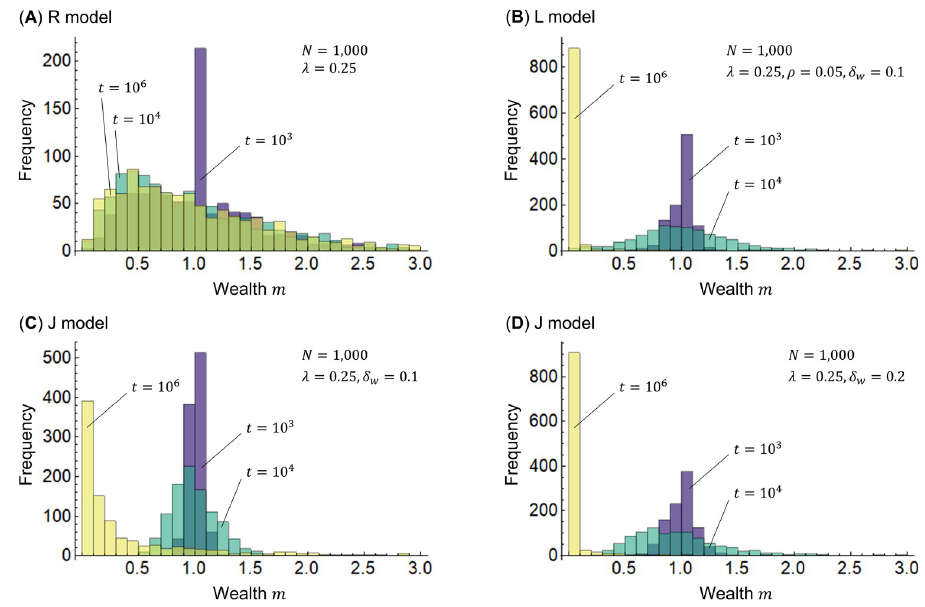
Fig 3. Wealth distributions for the R, L, and J models. (A) R model, (B) L model, and (C) and (D) J model. The horizontal axis represents wealth m , and the vertical axis represents frequency. In all models, the number of agents is N = 1000. The initial values of wealth at time t = 0 are m i (0) = 1 ( i = 1,2, ��� , N ). Since the average savings rate to GDP worldwide is roughly 0.25 [31], the savings rate here is λ = 0.25. In the L model, the interest rate is ρ = 0.05, and the width of the profit/loss rate δ is δ w = 0.1; in the J model, δ w = 0.1 and 0.2, so the effect of the profit/loss rate δ can be observed. To determine the change in wealth distribution, time (number of exchange repetitions) is t = 10 3 , 10 4 , and 10 5 .